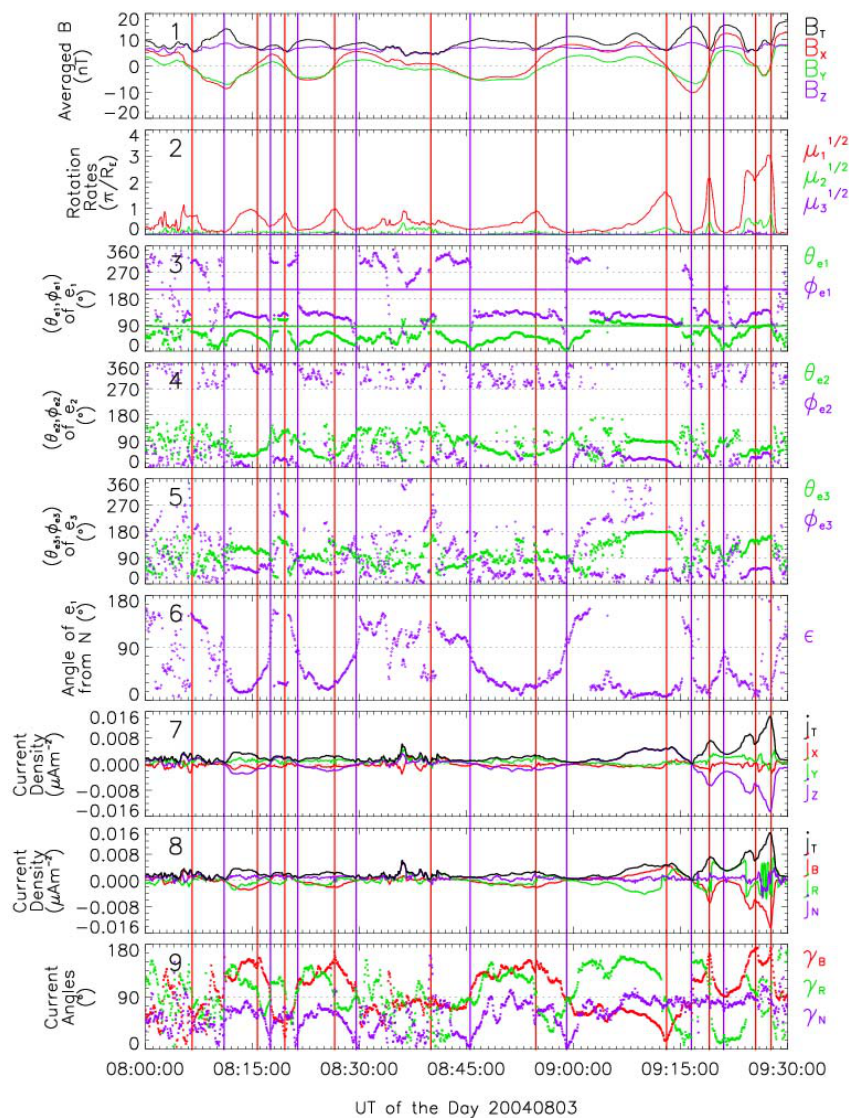
Fig. 7b. The geometric structure of the tilted current sheet during a series of Cluster crossings on 3 August 2004. The format of the figure is the same as Fig. 1b.